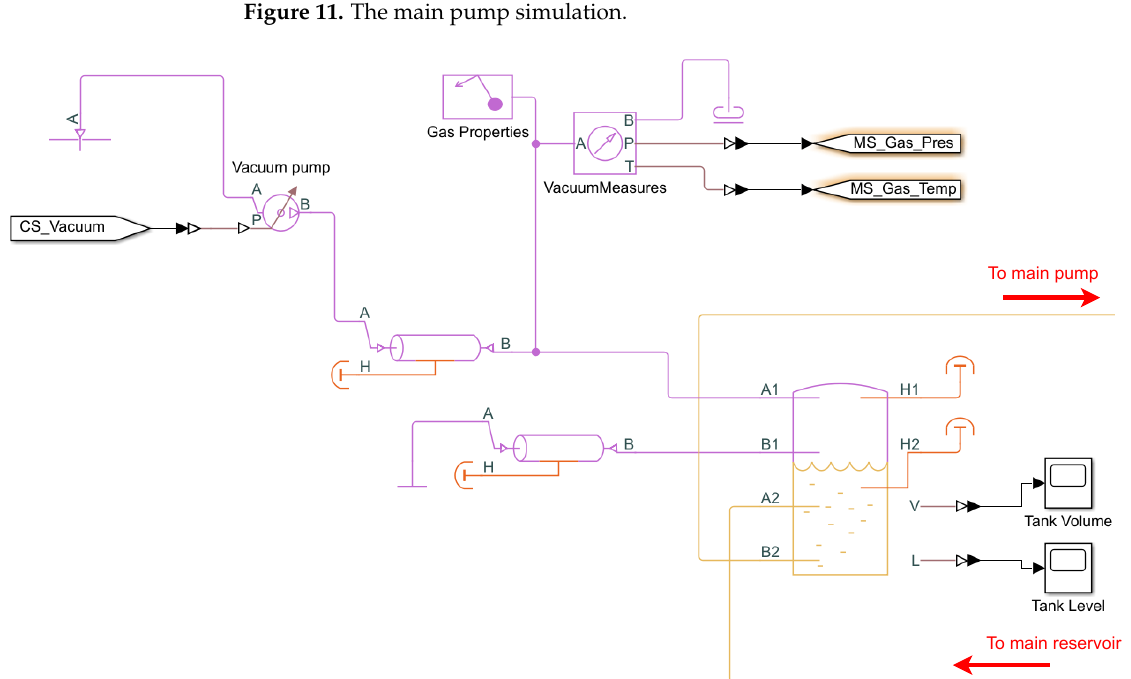
Figure 12. The reservoir